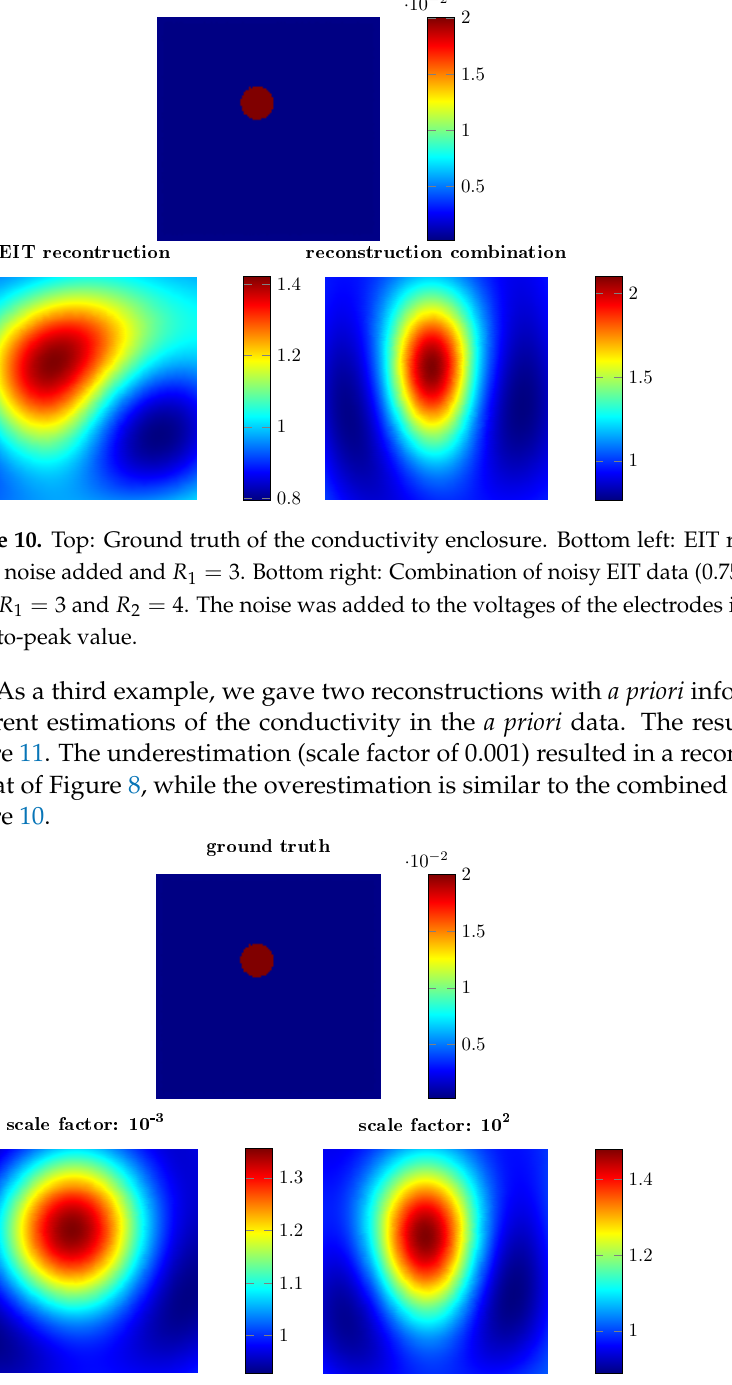
Figure 11. Visualization of under- and overestimation of the gourd truth conductivity. Top: Ground truth of the conductivity enclosure. Bottom left: Combination reconstruction with R 1 = 3 and R 2 = 4. The original conductivity of the enclosure is underestimated by a factor of 0.001. Bottom right: Combination reconstruction with R 1 = 3 and R 2 = 4. The original conductivity of the enclosure is overestimated by a factor of